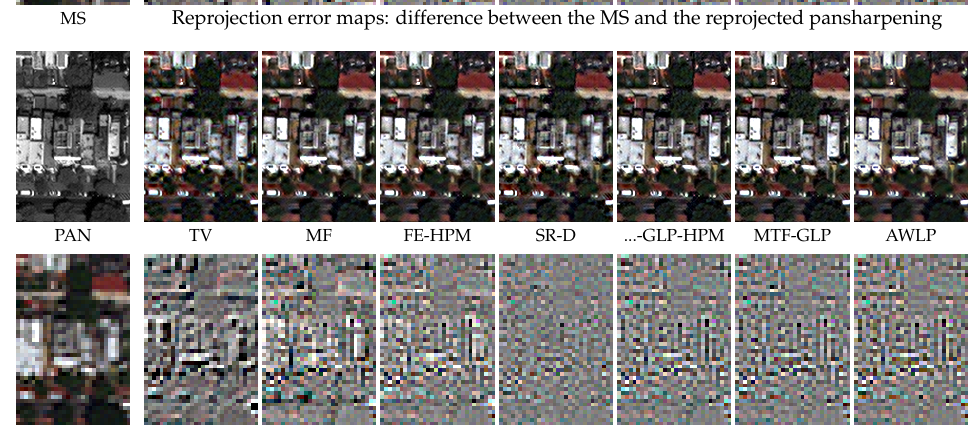
Figure 12. Sample crops from a WV2 sample image (Washington) and related full-resolution pansharpening. For each crop, in addition to the PAN and MS components ( left-most column), the best-performing solutions according to R- Q 2 n are shown from left to right in decreasing order, next to the PAN. For each method, both the R- Q 2 n and D ρ scores are reported on the bottom lines of the figure. Moreover, next to the MS, for each pansharpening result, the corresponding reprojection error map is